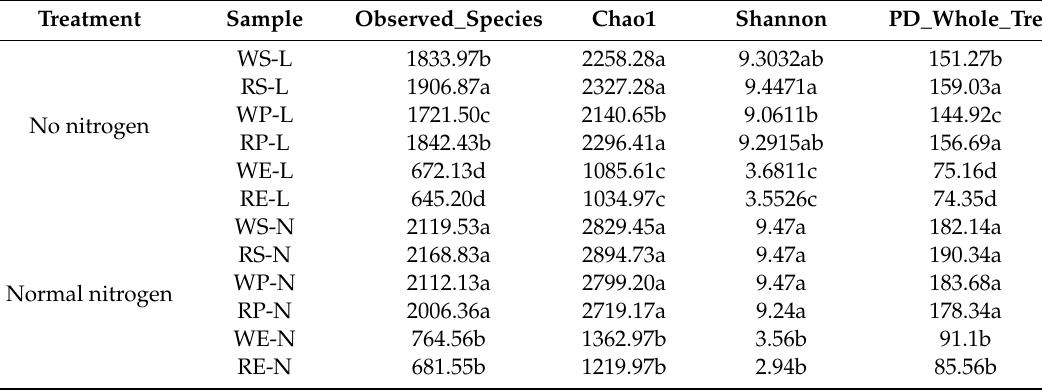
Table 3. Diversity index of bacterial communities in rice